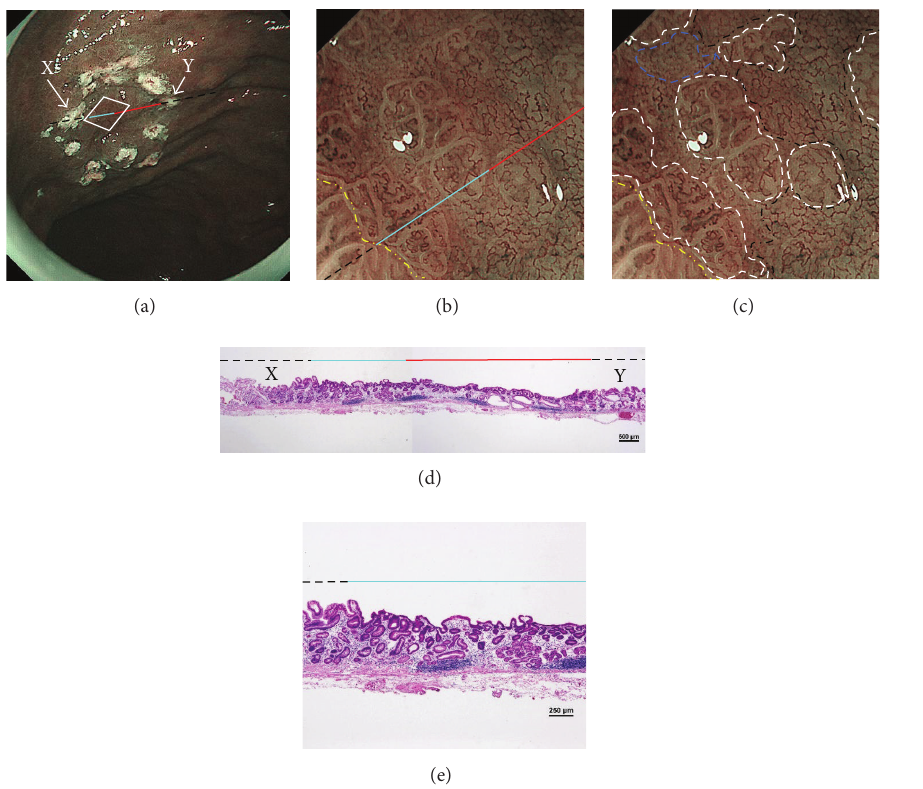
Figure 2: Endoscopic and histopathological findings of simple-type- (S-), low-grade- (LG-), well-differentiated tubular adenocarcinoma (tub1) (S-LG-tub1). (a) Low-magnification view of narrow-band imaging magnifying endoscopy (NBI-ME) shows a superficial depressed (0-IIc) lesion. The thin-broken, thin-solid, and thick-solid lines show the slice line within the specimen resected by endoscopic submucosal dissection (ESD). The thin-broken, thin-solid, and thick-solid lines indicate the noncarcinomatous part, the same carcinomatous part that is shown in (b), (d), and (e), and the same carcinomatous part that is shown in (b) and (d), respectively. The slice line was decided along with those lines which linked X to Y cautery markings. The X and Y markings are shown in (a) and (d) as landmarks in the NBI view and HE-stained histological specimens, respectively. (b) High-magnification NBI-ME (boxed area in (a)). The two-dot chain line demarcates the carcinomatous and noncarcinomatous areas. The thin-broken, thin-solid, and thick-solid lines are the same lines in (a), (d), and (e). (c) The sameviewof(b)revealsregularmeshpattern(RMP)withloosemeshpattern(LMP),loopswithinirregularpolygonalandpapillarystructures (LIPPS), ultra-fine granular pattern (u-FGP) (surrounded by one-dot chain, short-dotted, and broken lines, resp.), and a “minute transitional zone” (outside the lines) in a single lesion. The two-dot chain line demarcates the carcinomatous and noncarcinomatous areas. The limited- to-four-pattern (LFP) sign-positive lesions included a “minute transitional zone” between any of the four aforementioned types, whereas the LFP sign-negative lesions apparently included other patterns that could not be classified into any of the four aforementioned types. The width of a “minute transitional zone” was defined as < 500 𝜇 m; because the highest-magnification view is 4 × 4 mm, we could recognize the widths of a “minute transitional zone” less than one-eighth of the quadrangular side, which is 500 𝜇 m. This lesion was diagnosed by NBI-ME as a simple-type- (S-), low-grade- (LG-), well-differentiated tubular adenocarcinoma (tub1) (S-LG-tub1). (d) Low-magnification view of a post-ESD specimen and (e) moderately magnified view of a post-ESD specimen present S-LG-tub1. Histological examination corroborated the NBI-ME